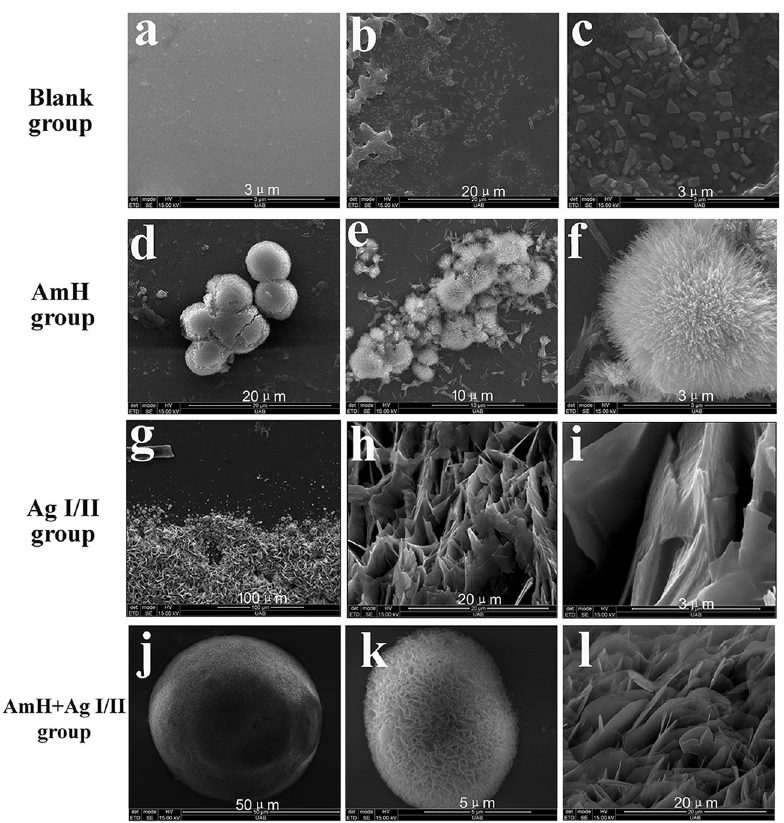
( d ) globular crystals in 3–5 μm diameters, scatted in knots; ( e ) between the globules, needles/rods were bound together in bundles; ( f ) thousands of needles/rods grow from the core and looks like a hedgehog. ( g – i ) Ag I/ II group, ( g ) dense flake crystals cover the surface; ( h ) flake crystals standing at random; ( i ) flake crystals with irregular shape. ( j – k ) AmH + Ag I/II group, ( j ) isolated globular crystals, with diameter from 5 to 40 μm; ( k ) petal-like crystals aggregate into globule; ( l ) petal